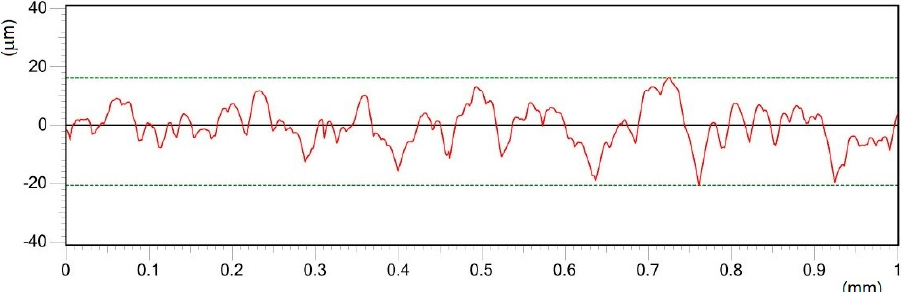
Figure 8. Roughness profile of surface C in Y direction treated by pulse energy of 0.6 mJ; Ra 6.15 μ m.